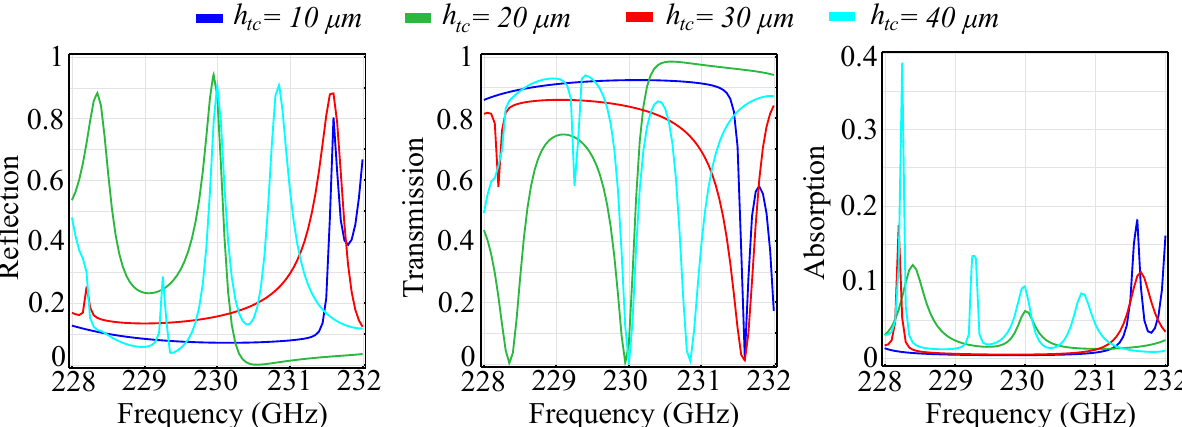
Figure 8. Simulated reflection, transmission, and absorption coefficients for fixed ring-cone height ( h c ) values in the silicon substrate unit cell